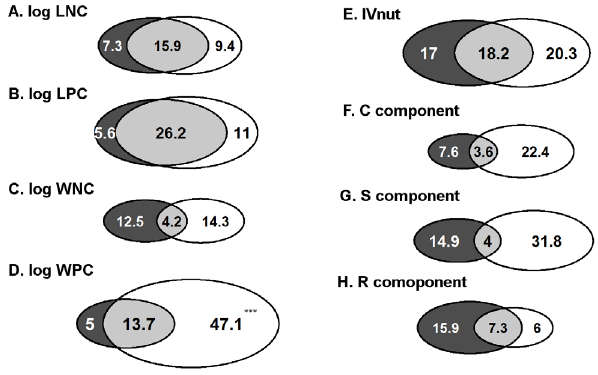
Figure 1. Partitioning of among-site plant trait variation. Trait variations (in percentage of variance) are divided into unique effects of soil N measures (dark grey), unique effects of soil P measures (white), and shared effects of both (light grey). Examined plot-mean plant traits are A: log-transformed leaf N concentration, LNC (mg/g) ( n =51), B: log- transformed leaf P concentration, LPC (mg/g) ( n= 51), C: log-trans- formed N concentration of above-ground plant biomass, WNC (mg/g) ( n= 82), D: log-transformed P concentration of above-ground plant biomass, WPC (mg/g) ( n= 82), E: indicator value for nutrients, IV nut ( n= 134), F: C component ( n= 134), G: S component ( n= 134), and H: R component ( n= 134). When the contribution of N or P measures to the total explained variance is significantly larger than the other, this is indicated by asterisks ( *** : p , 0.001). doi:10.1371/journal.pone.0083735.g001 Fig. 1F) and the R component (29.3%, Fig. 1H). Shared effects